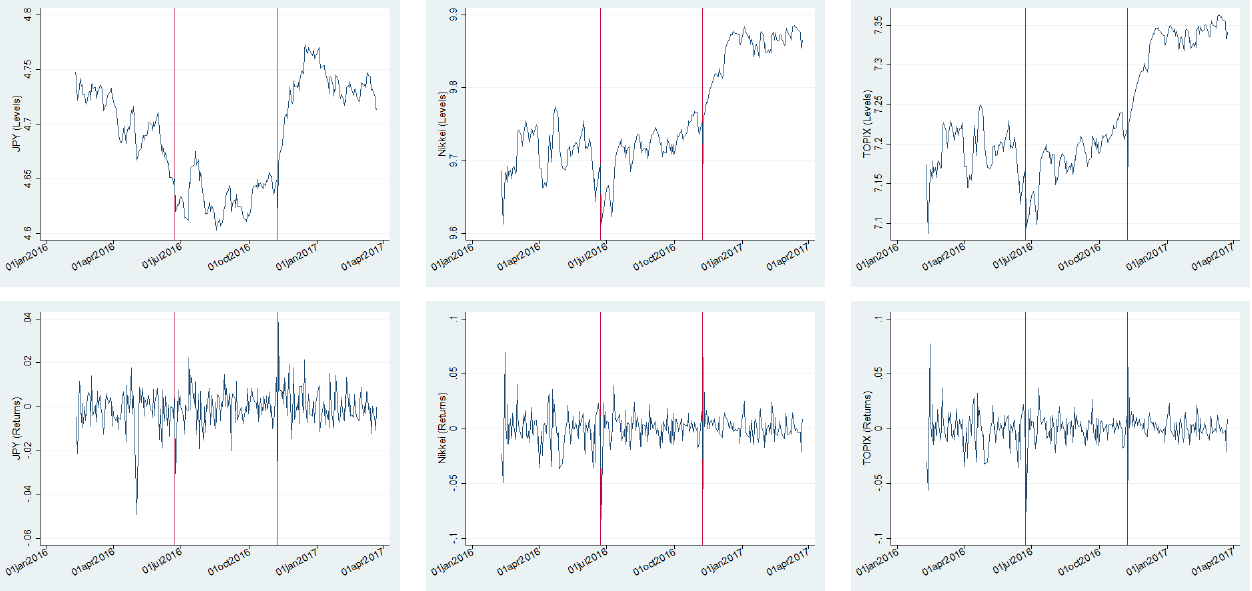
Figure 1. Levels and returns of JPY, Nikkei and TOPIX. Author’s estimations based on the data from the Bank of Japan, TSE and Yahoo Finance. The levels are the logarithmic values of the variables. The returns are the daily logarithmic differences of the variables.